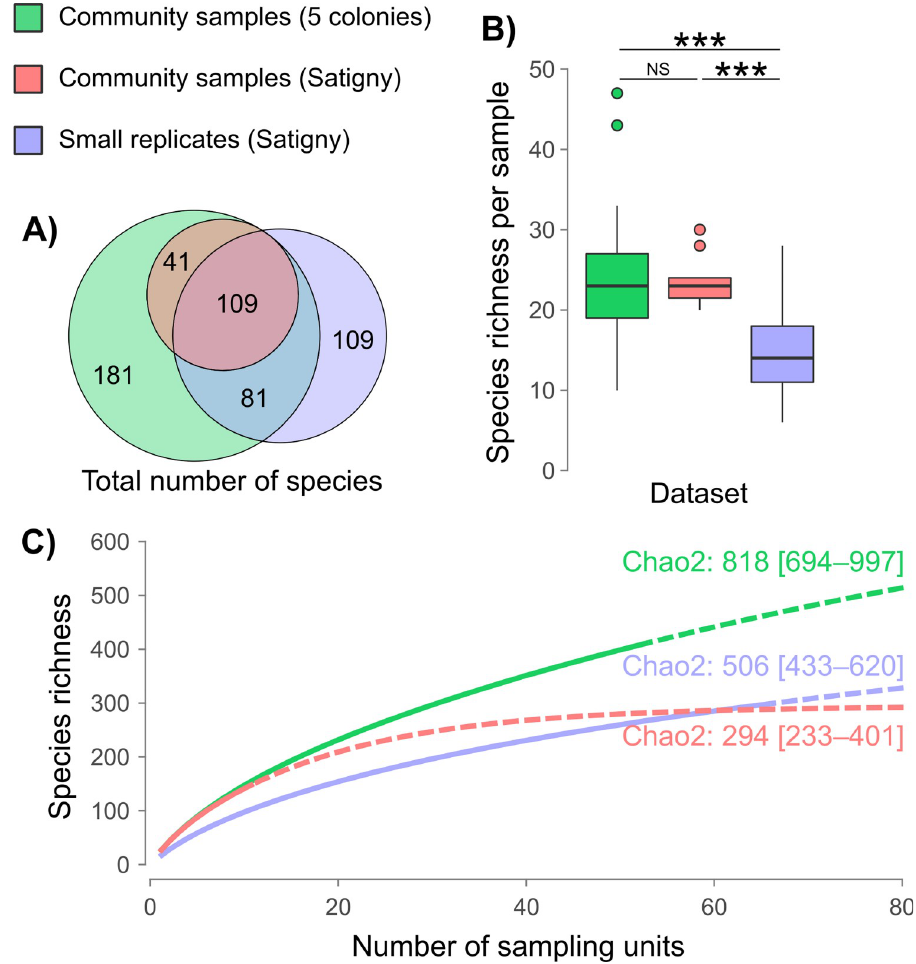
Fig 2. Species diversity statistics for different regimes of guano sampling: Community samples for all colonies in green (n = 53), community samples for the Satigny colony in red (n = 11), and small replicates in blue (n = 66). A) Area-proportional Euler diagram of the total species diversity found under each sampling regime. B) Number of species per sample, with significant differences between sampling regimes indicated by stars ( ��� P < 0.001). C) Extrapolated accumulation curves of the number of detected prey species for each sampling